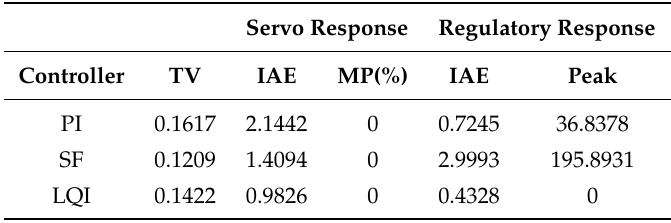
Table 5. Performance indices of the perturbed closed-loop responses ( D = 0.4 and R o =